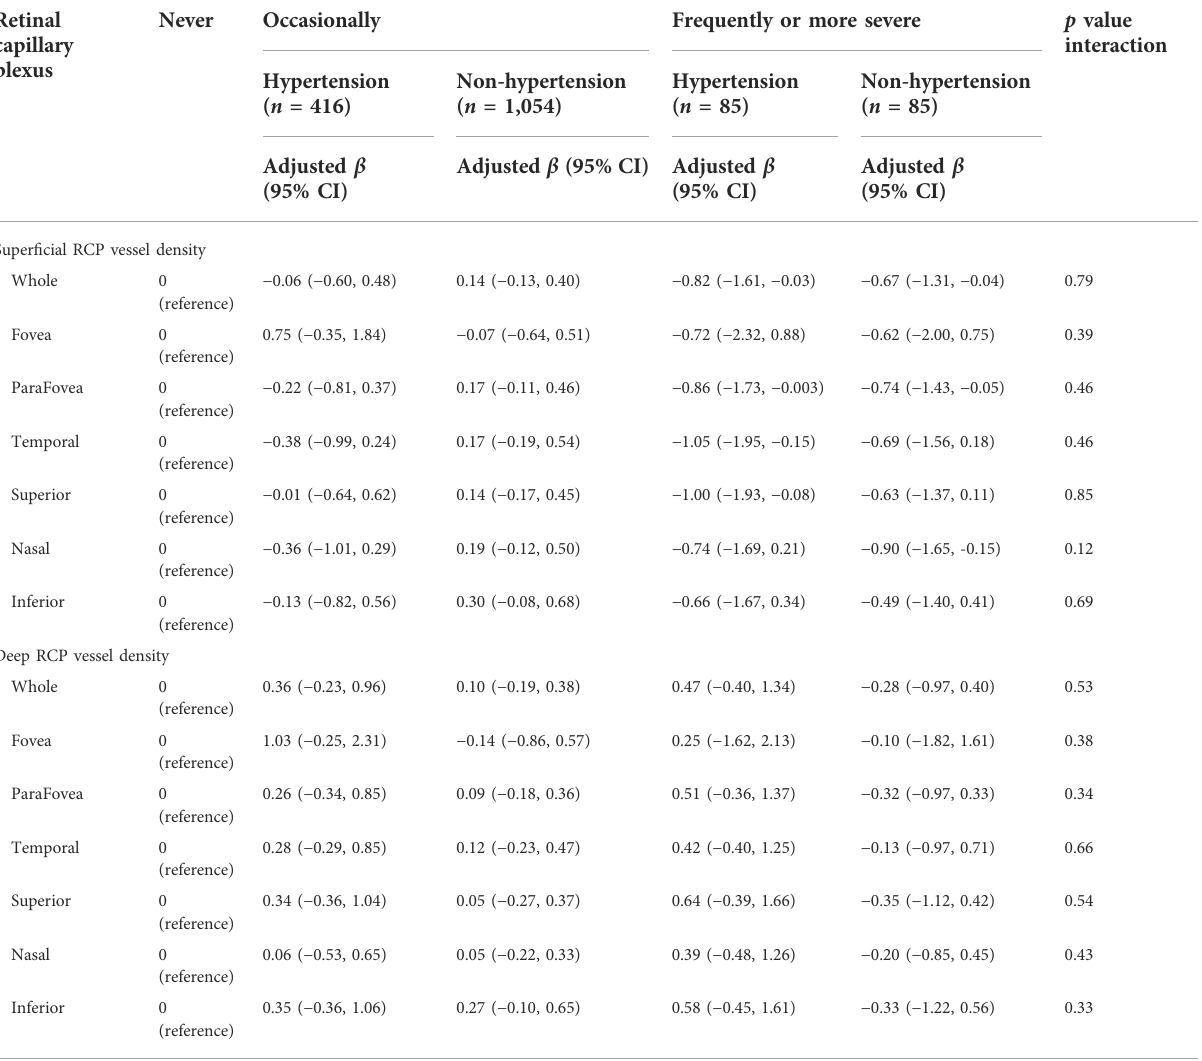
TABLE 4 Associations of self-reported snoring with retinal capillary plexus strati fi ed by hypertension. Retinal capillary